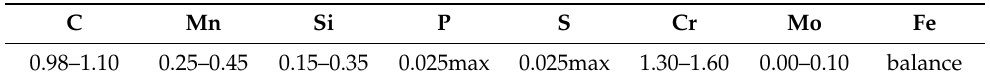
Table 1. The chemical composition (wt %) limits for AISI 52100.